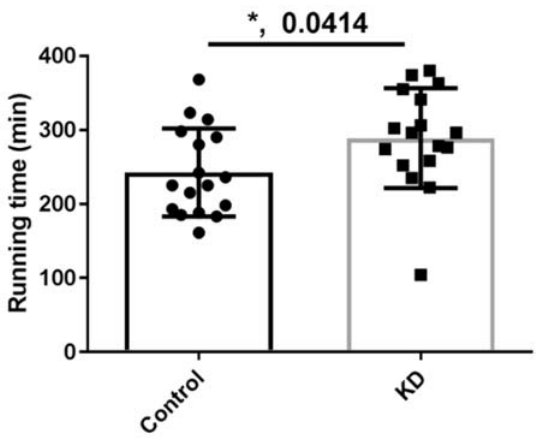
Figure 2. Performance of mice subjected to a chow-diet or ketogenic diet (KD). * p < 0.05, compared with the control group. n = 17 for each group.